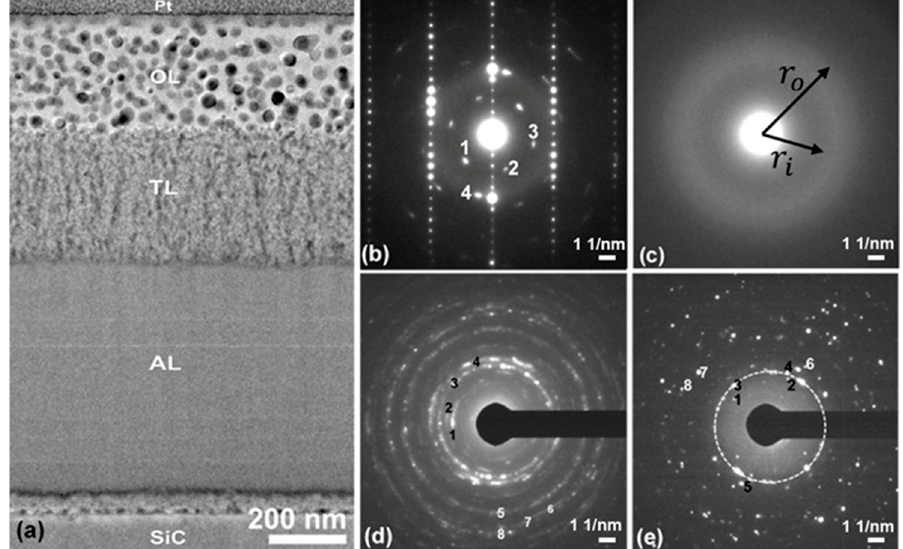
Figure 2. ( a ) Cross-section TEM image of the annealed Hf 6 B 10 Si 31 C 2 N 50 film. SAED pattern taken from ( b ) substrate, ( c ) amorphous layer, ( d ) transition layer and ( e ) top oxide layer shown in ( a ). The top oxide layer exhibits nearly the same microstructure as in the annealed Hf 7 B 23 Si 17 C 4 N 45 [25,27], Hf 6 B 21 Si 19 C 4 N 47 and Hf 7 B 23 Si 22 C 6 N 40 films [26,28] studied previously, whereas the layers